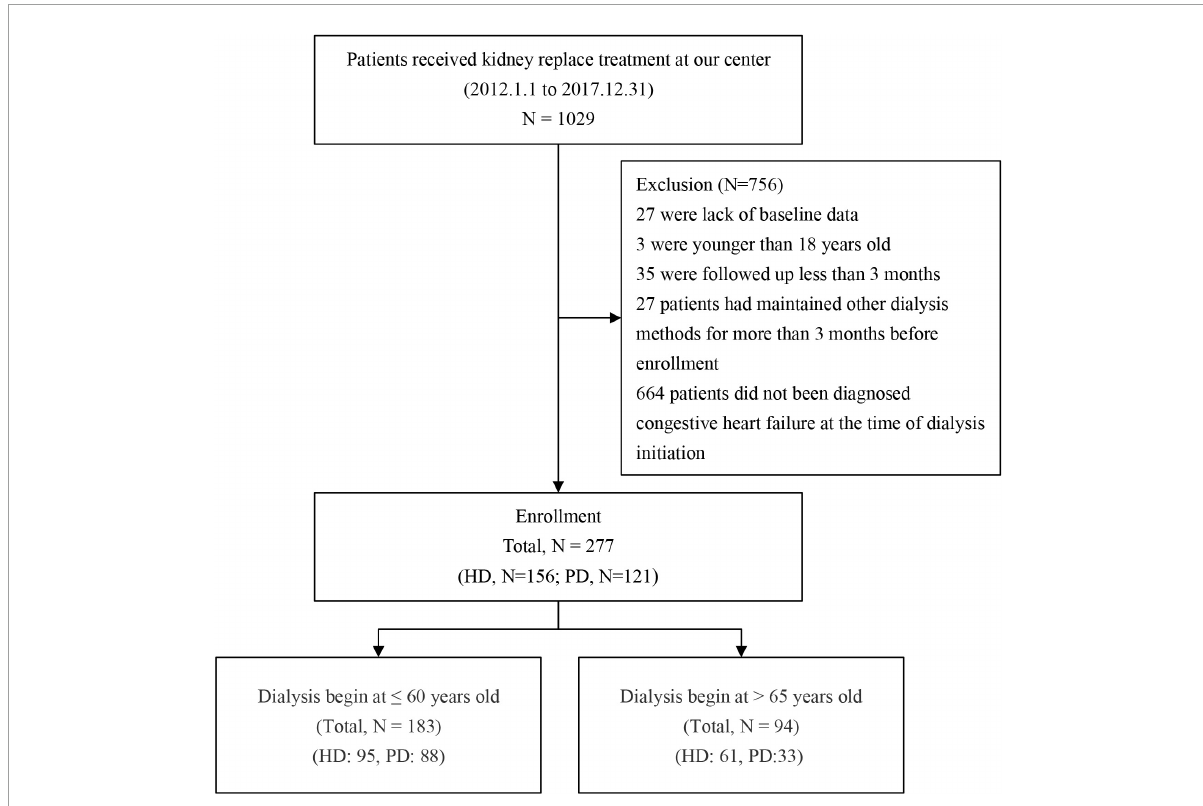
FIGURE1 Study flow